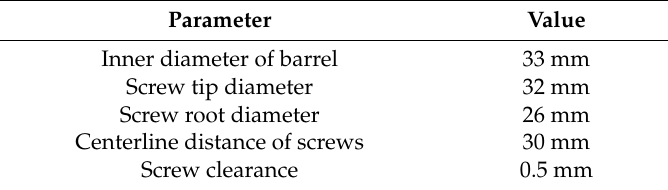
Table 1. Parameters of geometric model of the extruder.